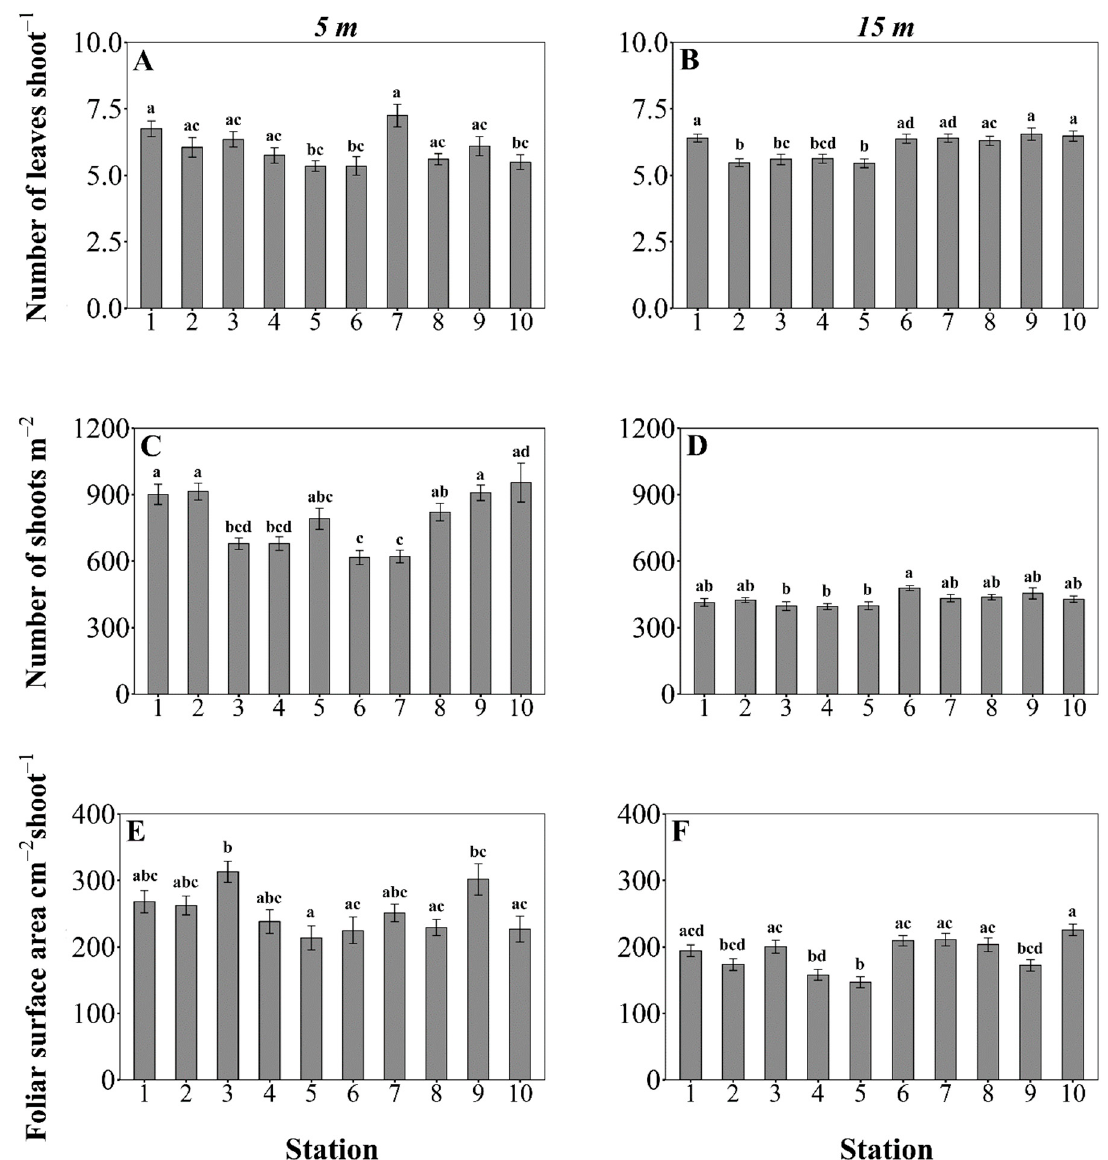
Figure 4. Posidonia oceanica descriptors at 5 m and 15 m depth sampling stations. The mean number of leaves and foliar surface were calculated from 20 and 40 shoots for the 5 m and 15 m depth stations, respectively. The mean shoot density was calculated from 20 replicate measurements in 0.16 m 2 quadrats. The error bars represent the SE. Stations within each panel that do not share a letter are significantly different at p < 0.05. Pairwise comparisons in panels ( B ), ( E ) , and ( F ) were generated by Tukey’s (HSD) post-hoc test, and for panels ( A ), ( C ) , and ( D ) by Dunn’s post-hoc test with Bonferroni correction. About ten times higher LAI values (m 2 of seagrass canopy in 1 m 2 ) were recorded at